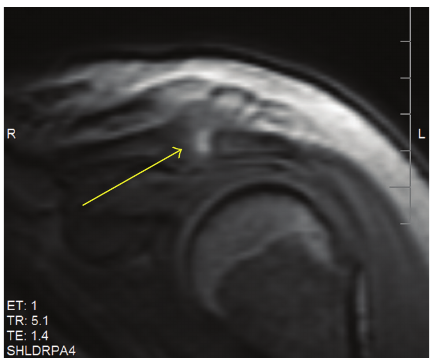
Figure 1: Left shoulder magnetic resonance imaging revealing edema within the acromioclavicular (AC) joint and edema and fluid outside of the joint. There is distal clavicular cortical destruction